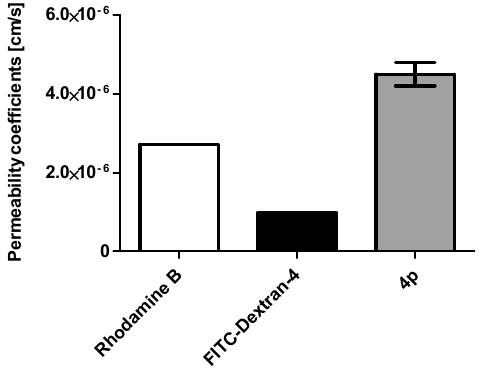
Figure 2 . Determination of the cell permeability of 4p using a Caco-2 assay based on human epithelial colecteral adenocarcinoma cells. Rhodamine B served as a positive control and FITC-dextran 4 as a negative control.